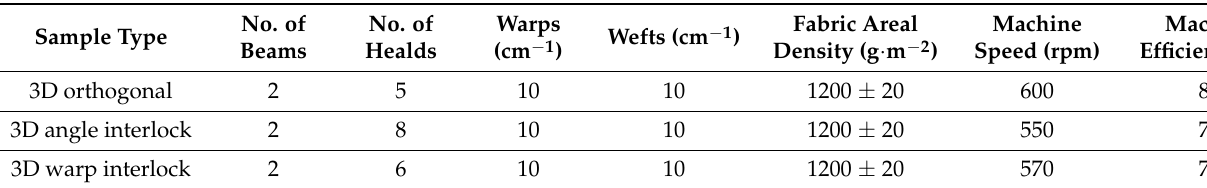
Table 1. Parameters of the weaving machine.